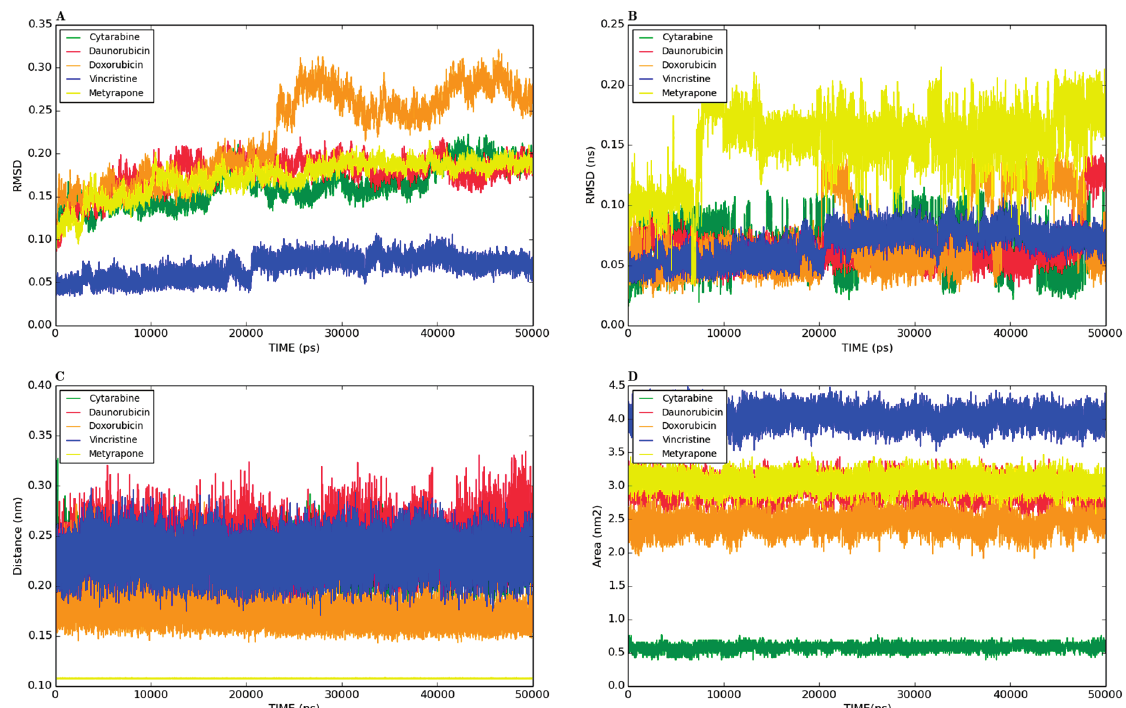
Figure 2. Analyses of the productive binding poses of cytarabine, daunorubicin, doxorubicin, vincristine, cytochrome (alone) and metyrapone (control) were subjected to 50-ns simulations. ( A ) Root mean square deviation (RMSD) of the protein backbone atoms, with respect to the initial structure; ( B ) drug RMSD, with respect to the initial structure; ( C ) The solvent accessible surface area for the drug complexes; ( D ) heme to drug distances measured.